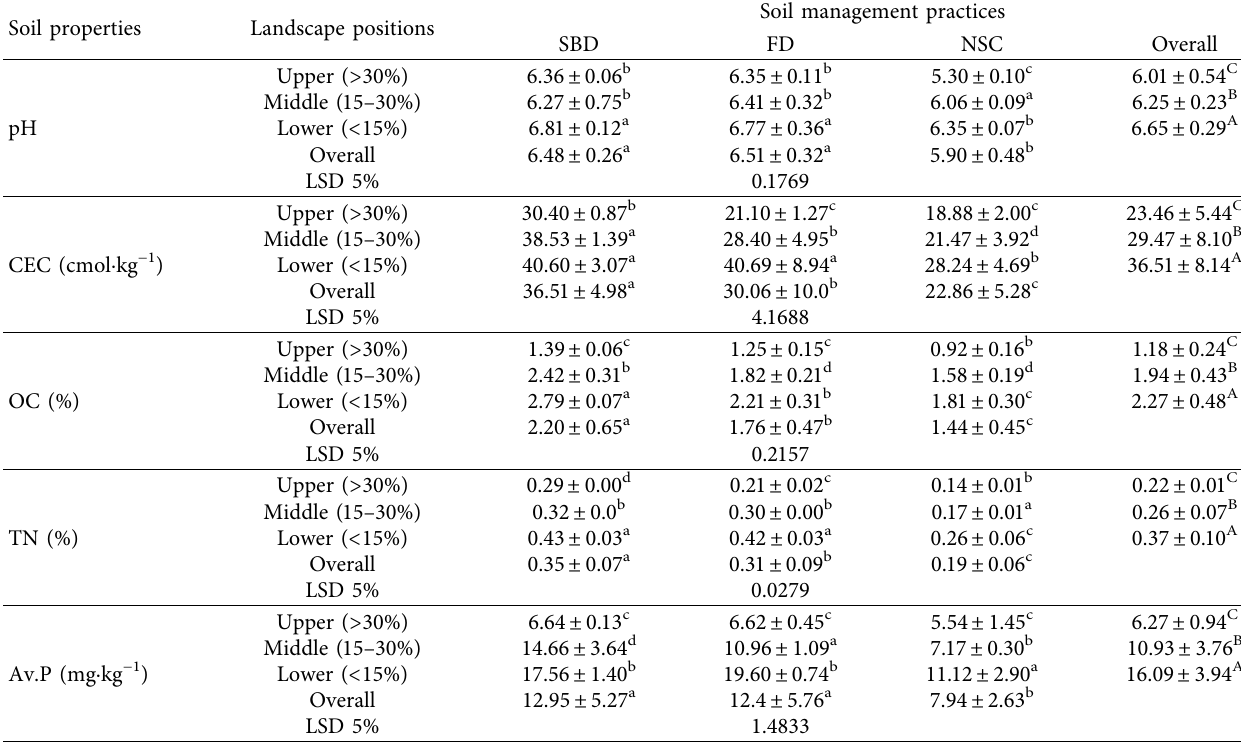
Table 4: Effect of soil management practices at different landscape positions on soil chemical properties. Landscape